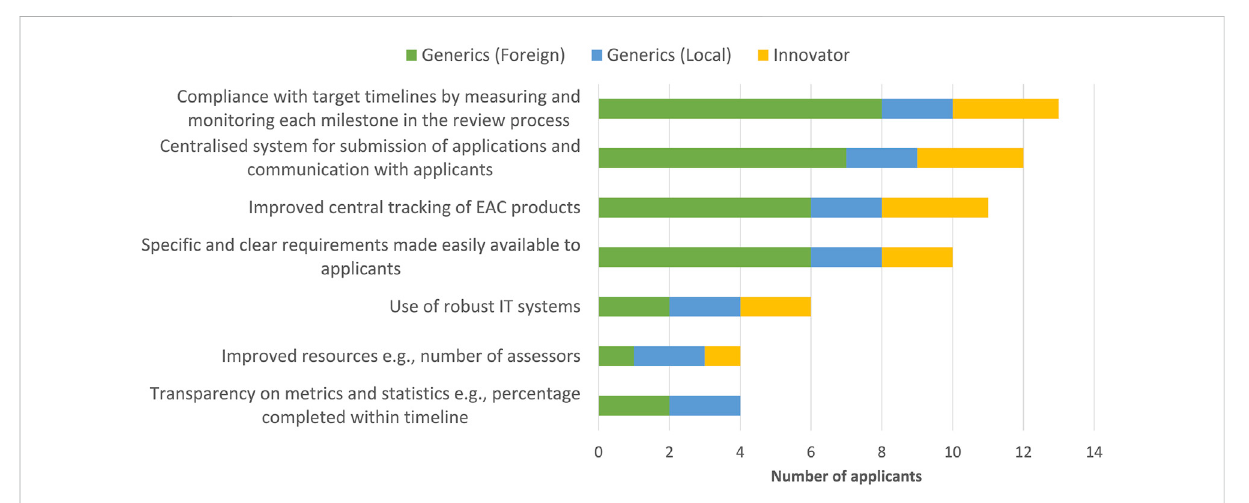
FIGURE 5 Ways to improve the ef fi ciency of the EAC